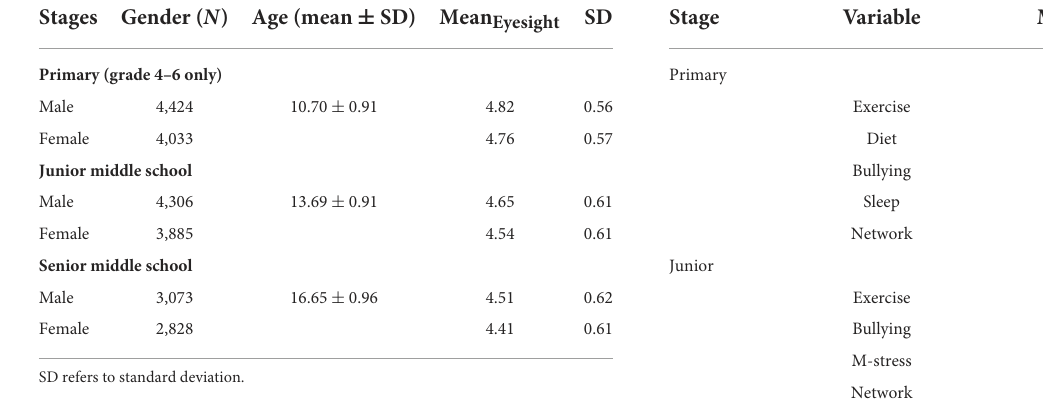
TABLE 1 The demographic and visual acuity of the final sample. TABLE 2 Average value of relevant